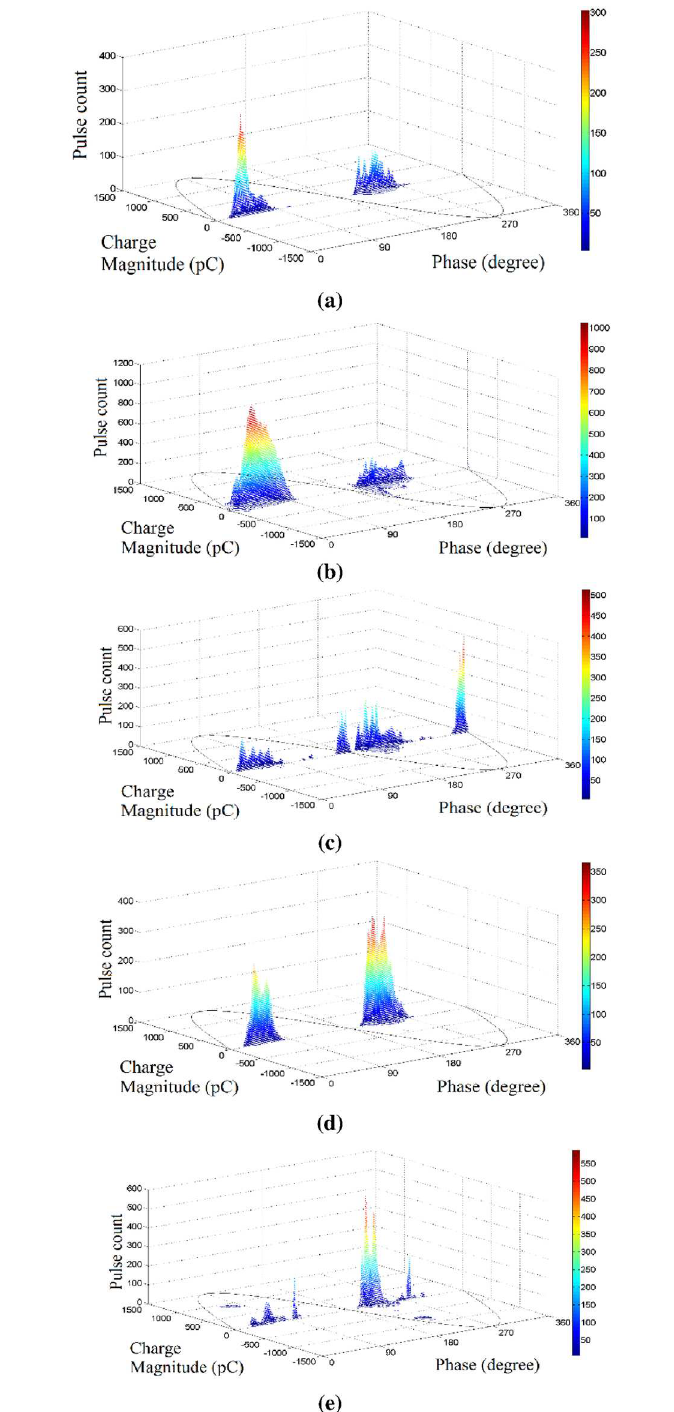
Fig 3. PRPD patterns from samples of different defects; (a) Insulation incision defect (b) axial direction shift defect, (c), semiconductor layer tip defect (d) metal particle on XLPE defect and (e) semiconductor layer air gap